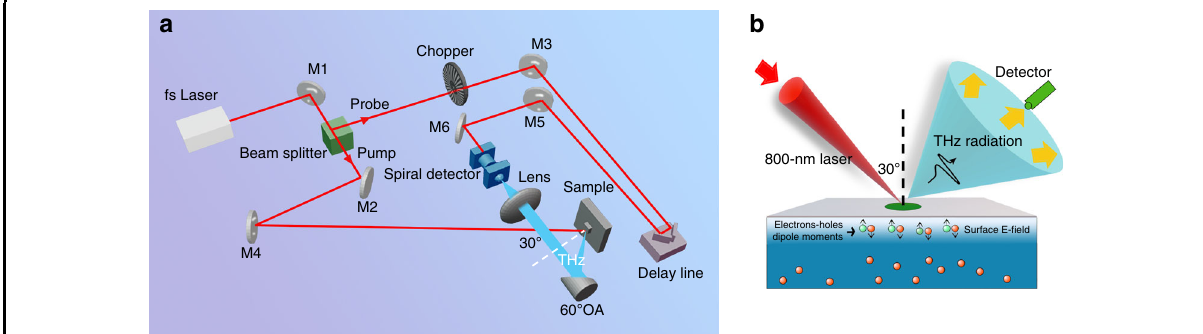
Fig. 8 Setup of the TES system and characterization of Si samples. a Diagram of the TES system for testing THz emission from the Si samples. b Diagram of THz emission characterization from Si samples